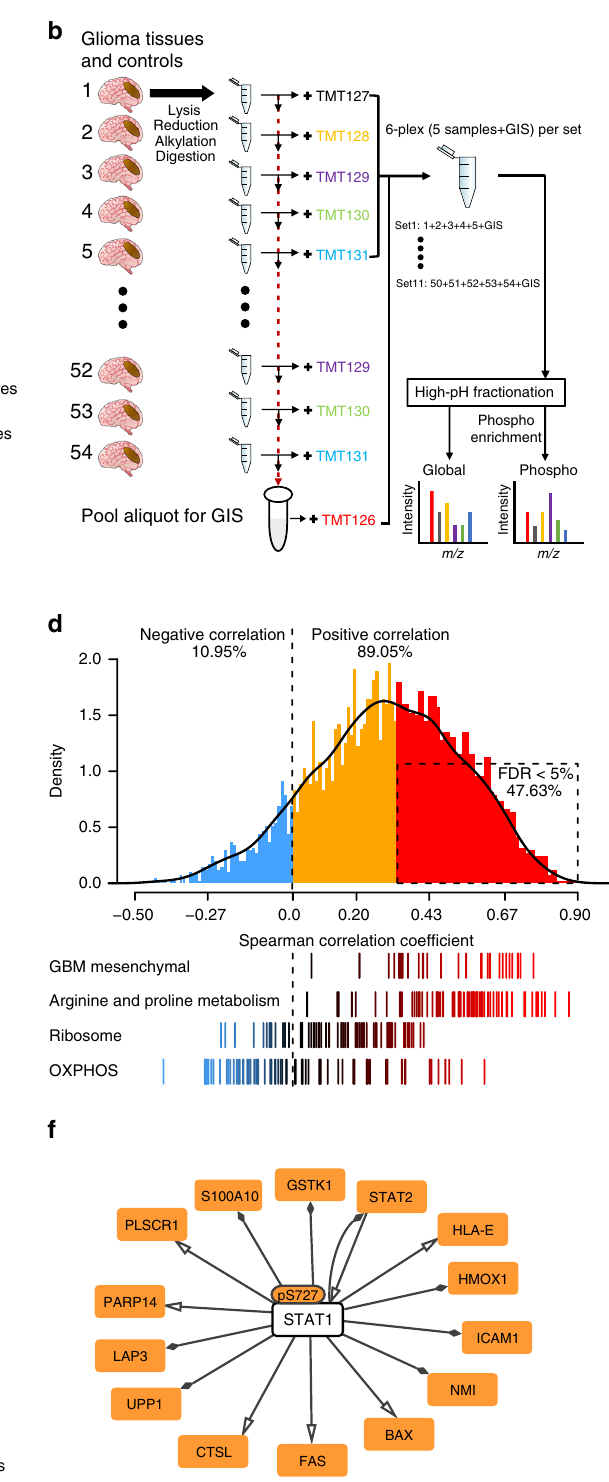
tumors (Supplementary Fig. 2a): the two IDH mutant GBMs were classi fi ed with GPC2 tumors, and the nine LGGs were